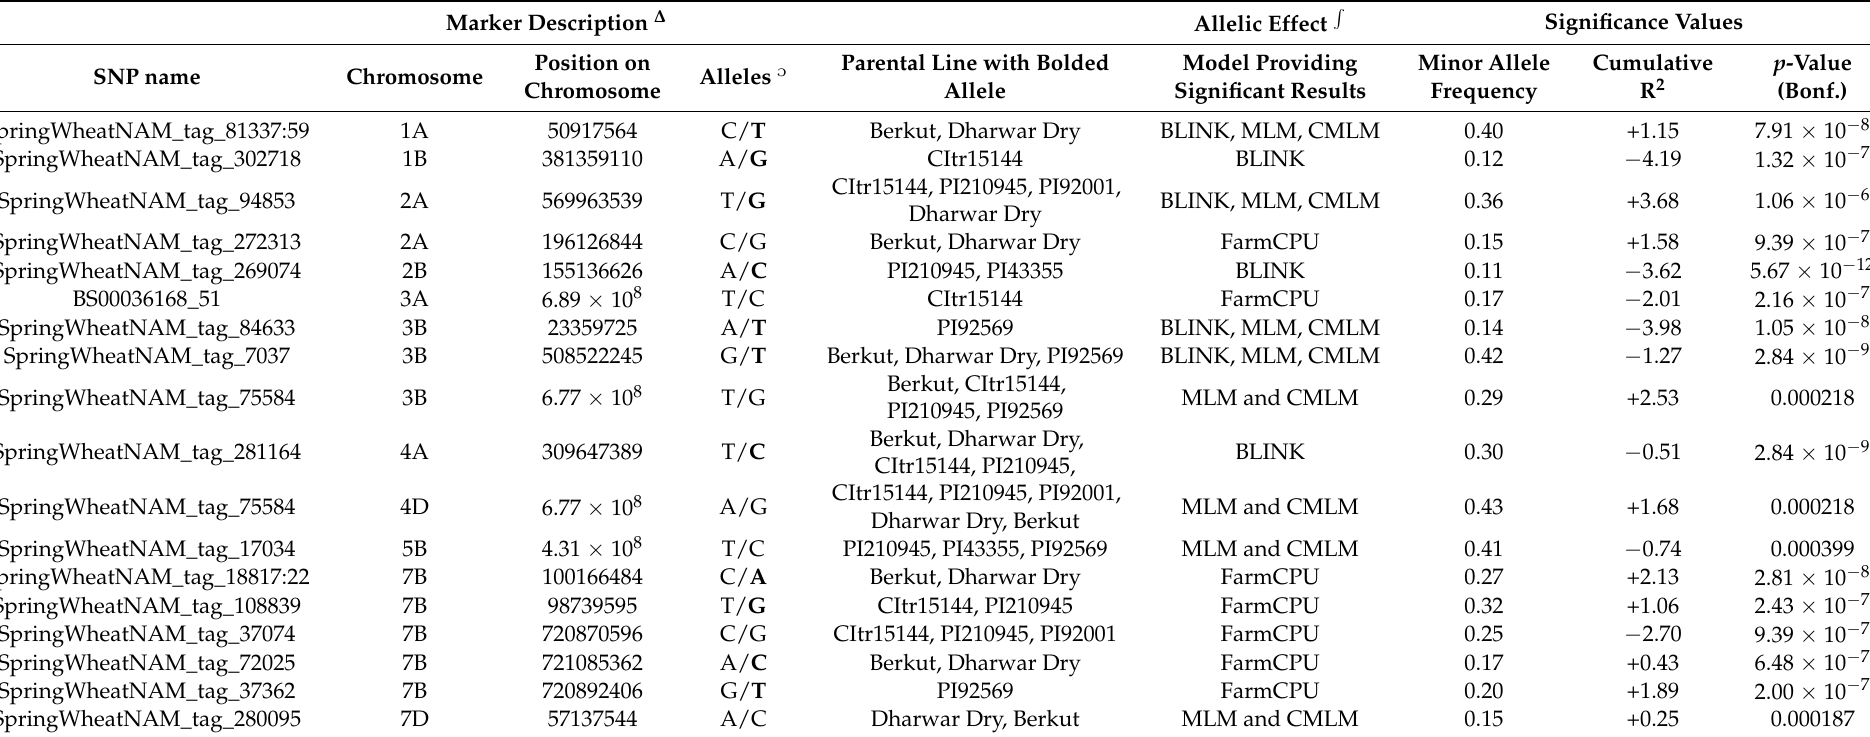
Table 1. Significant markers representing quantitative trait loci for grain protein content stability in a nested association mapping of hard spring wheat identified using four different GWAS